Question: Write a caption explaining this figure to a reader.
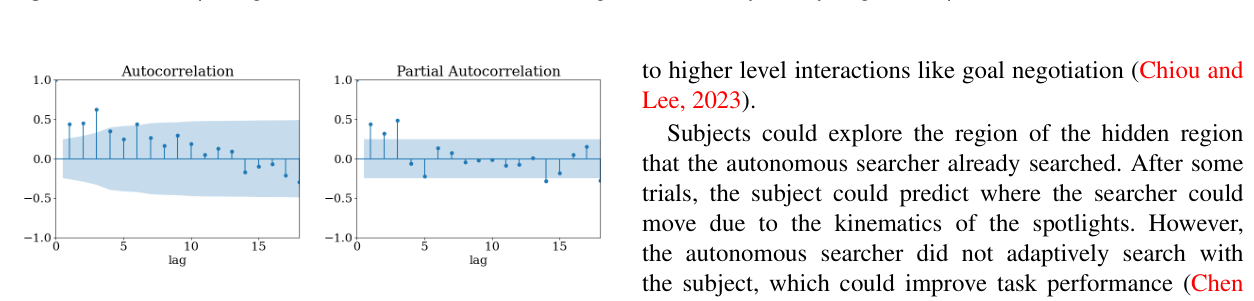
Answer: The Autocorrelation Function and Partial Autocorrelation Function plots of the residuals for Group 0 indicate lags 1 through 3 are likely necessary to capture the remaining error.